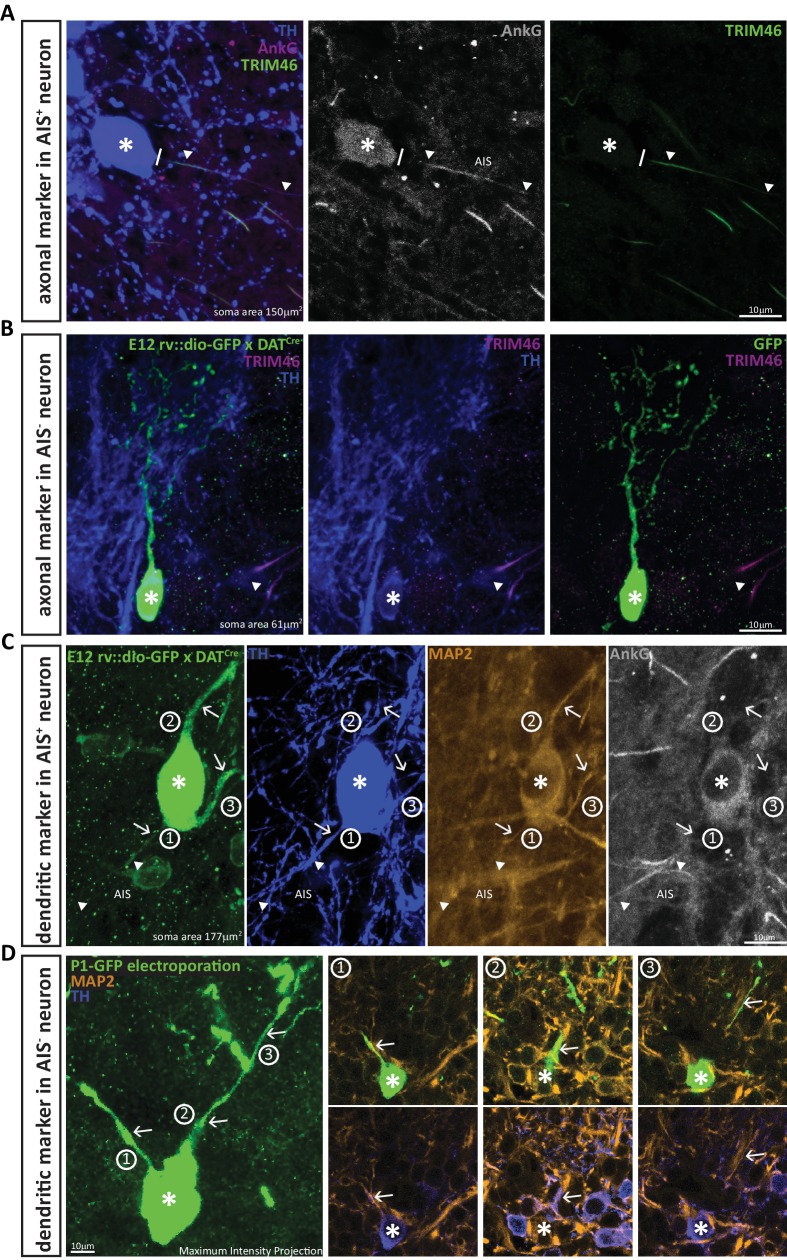
DA neurons that lack an AIS also lack the axonal marker TRIM-46, and all their processes co-stain with the dendritic marker MAP-2.(A) Example image of a DA cell in a wild-type mouse stained for TH (blue), AnkG (magenta) and the axonal marker TRIM-46 (green). Asterisks indicate soma position; lines indicate the emergence of the axonal process from the soma; triangles indicate AIS start and end positions. (B) Example image of an anaxonic DA cell in a DAT-Cre mouse injected at E12 with rv::dio-GFP, stained for TH (blue) and TRIM-46 (magenta). Asterisks indicate soma position; triangle shows a TRIM-46- and TH-positive process belonging to a neighbouring, non-GFP-expressing cell. (C) Example image of an AIS-containing DA cell in a DAT-Cre mouse injected at E12 with rv::dio-GFP, stained for TH (blue), MAP-2 (orange) and AnkG (grey). Asterisks indicate soma position; triangles indicate AIS start and end positions; numbers and arrows indicate the three main processes emerging from the soma. Note that MAP-2 fluorescence in the axon (process 1) ends when AnkG fluorescence begins. (D) Left: Maximum intensity projection image of an anaxonic DA cell in a wild-type mouse electroporated with GFP at P1, stained for TH (blue) and MAP-2 (orange). The asterisks indicates soma position; numbers and arrows indicate the three main processes emerging from the soma. Right: panels 1–3 show single z-plane images of each dendritic process, visualised with GFP plus MAP-2 label (top) or TH plus MAP-2 label (bottom). Note that all processes are positive for all three markers.